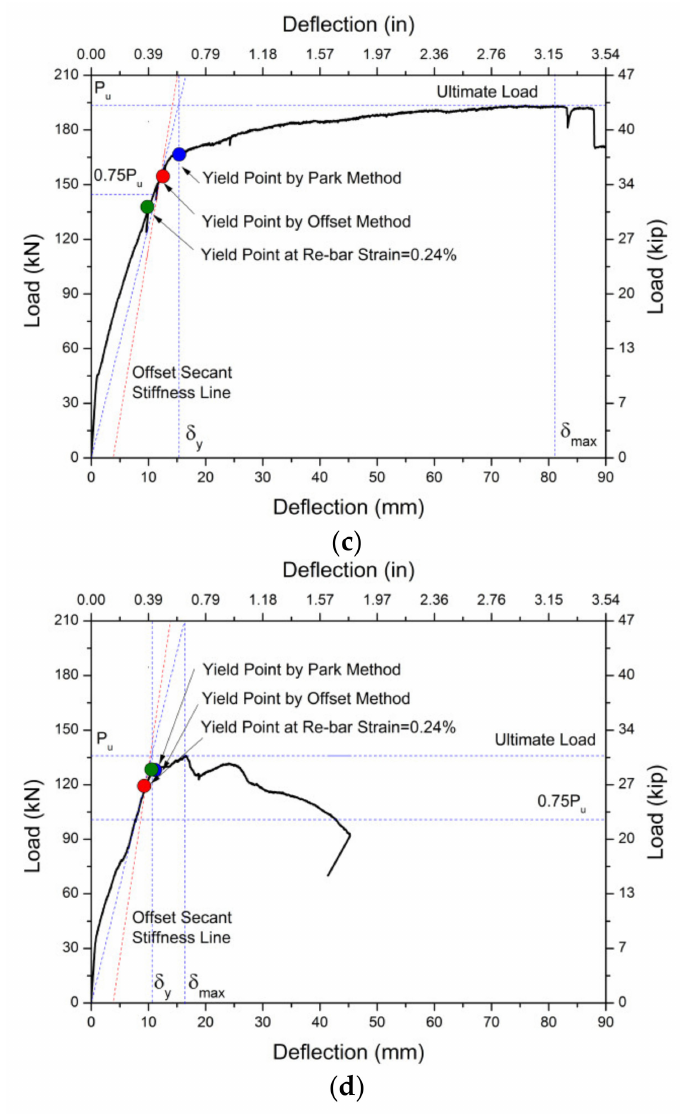
Figure 14. Yield points of the test specimens: ( a ) Solid; ( b ) OF-V-S-D; ( c ) OF-V-M-D; ( d )